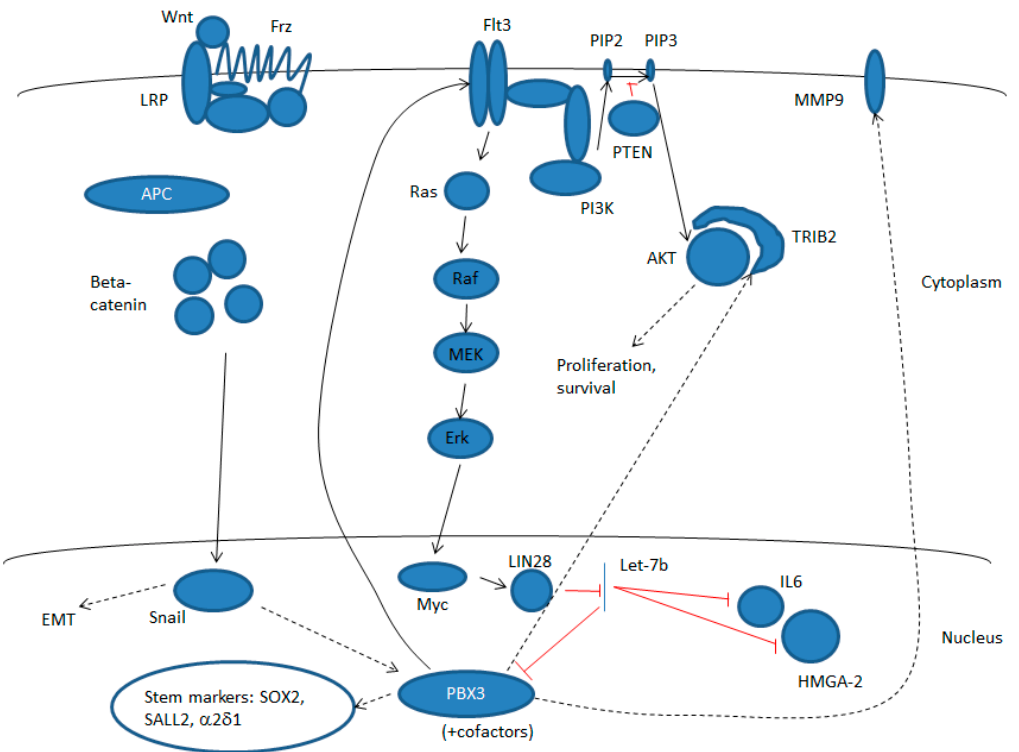
Figure 1. Pre-B cell leukemia (PBX3) is a target and a regulator of multiple signaling pathways. These include the MEK/ERK pathway, and notably tyrosine kinase receptor Flt3. Activation of this pathway represents a positive feedback loop in which increased expression of the Myc transcription factor activates LIN28 expression, which in turn inhibits biogenesis of miR-let-7b, an miR that blocks PBX3 expression post-transcriptionally. PBX3 also increases signaling through the AKT pathway by activating expression of the AKT activator protein, TRIP2. In addition, PBX3 expression increases in response to the signaling through the canonical WNT pathway via the activation of the Snail transcription factor. Activation of PBX3 through these pathways increases epithelial-to-mesenchymal transition (EMT) and hence invasion and metastasis (in part through increasing MMP9, IL6, and HMGA-2 expression) as well as cell survival and proliferation, and can also confer a TIC phenotype through upregulation of the SOX2 and SALL2 transcription factors and voltage-gated calcium channel α 2 δ 1. Dashed lines represent indirect pathways involving multiple steps and additional components.